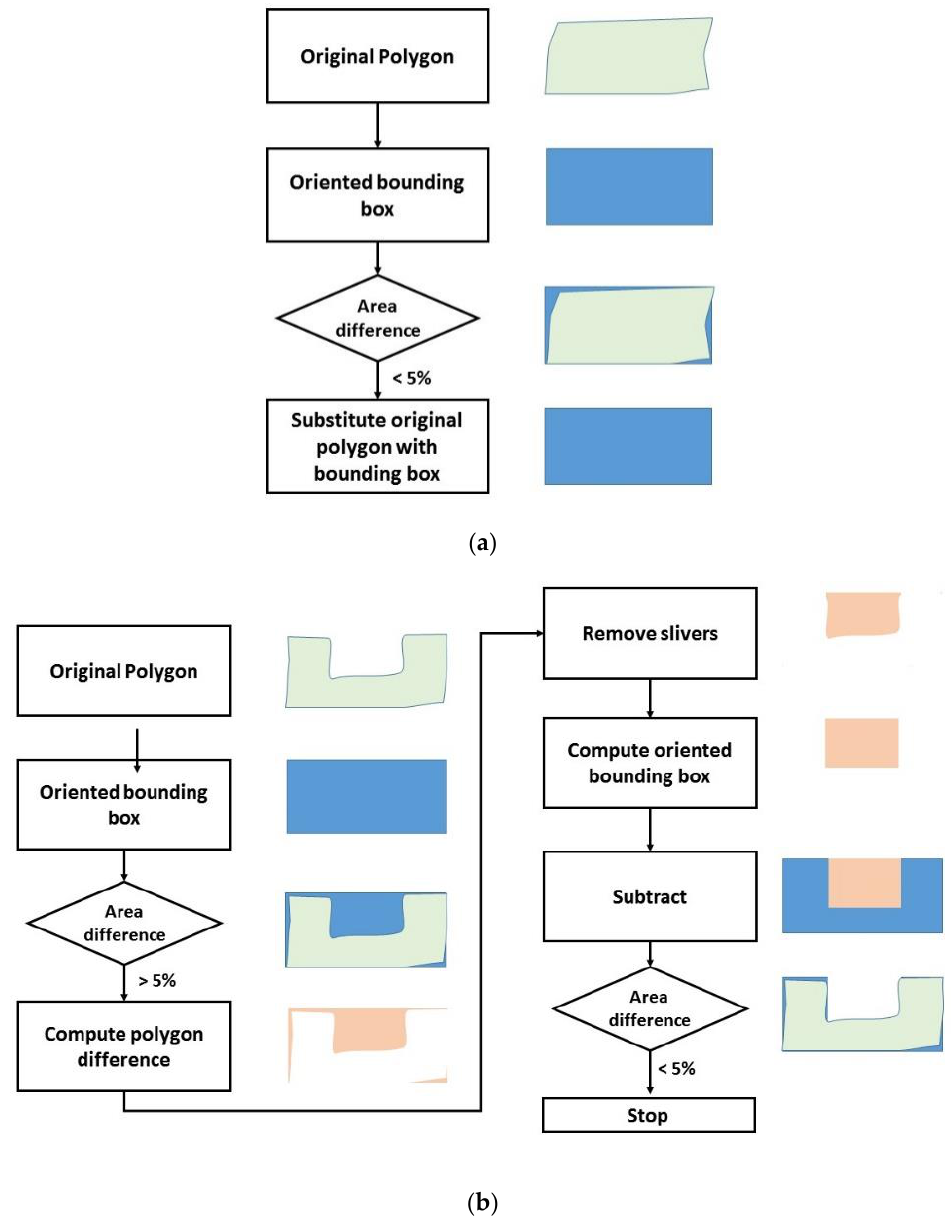
Figure 17. Building regularization example: the case of a rectangular-like building ( a ) and the case of a more complex building plan ( b ).